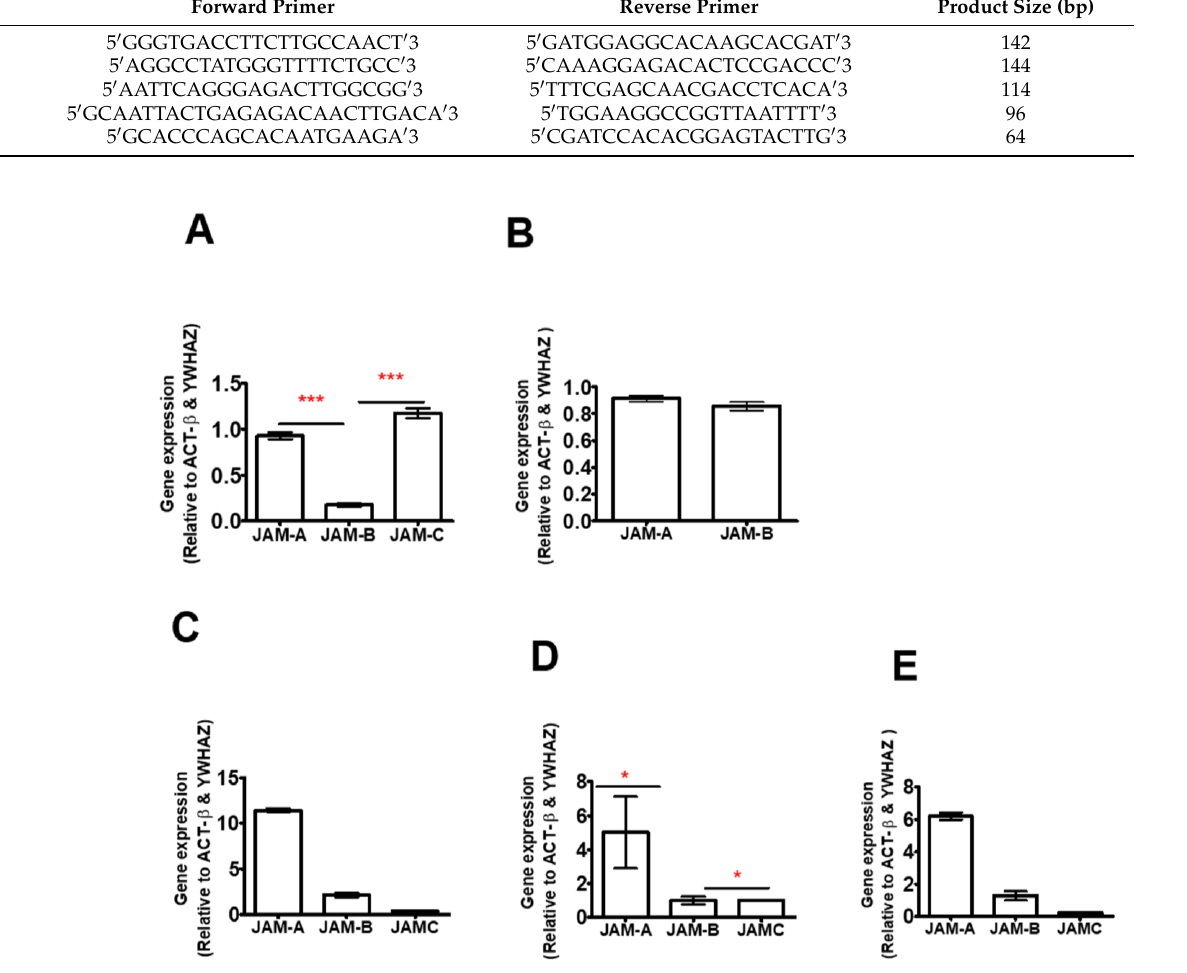
Figure 1. Relative gene expression of JAMs in ( A ) THP-1 monocytes, ( B ) PMA-differentiated THP-1 macrophages, ( C ) primary human monocytes, ( D ) differentiated primary macrophages and ( E ) peripheral blood mononuclear cells (PBMC). * indicates p ≤ 0.05 *** indicates p ≤ 0.0001 in comparison to each other. n = 3 for cell lines and n = 1 donor with 3 replicates for primary cells as such statistics not carried out for primary cells. Data are mean ± SEM.